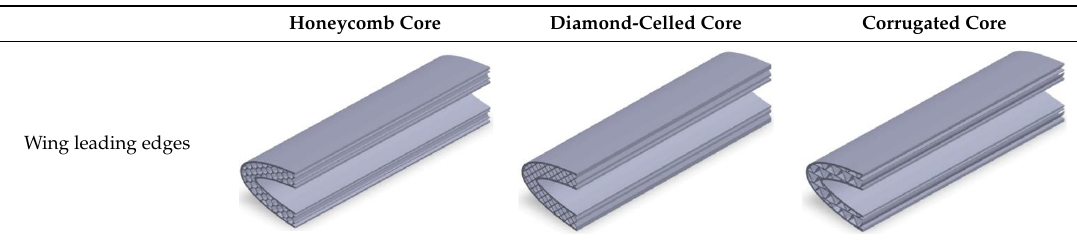
Table 2. Wing leading edges specimens.